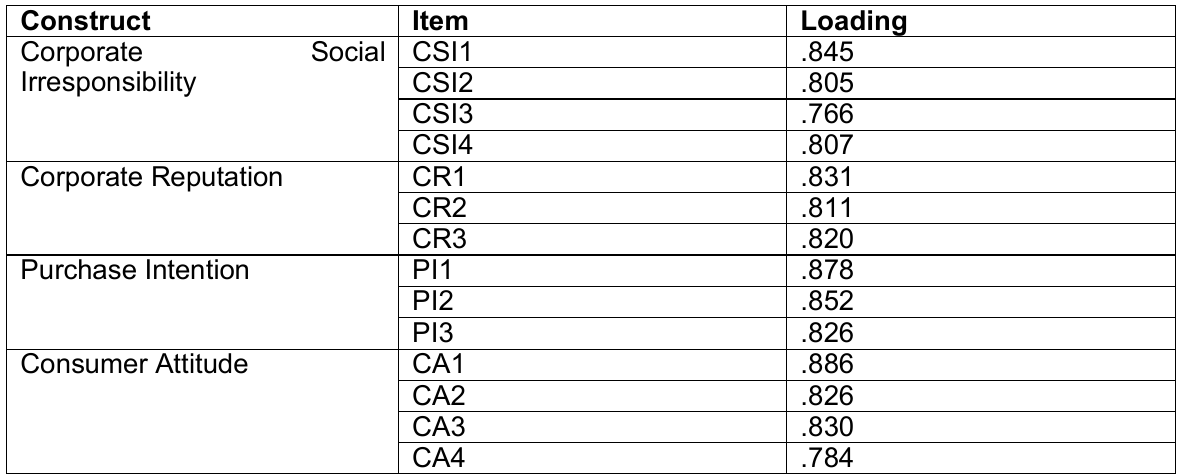
Table 2: Results of standardized item